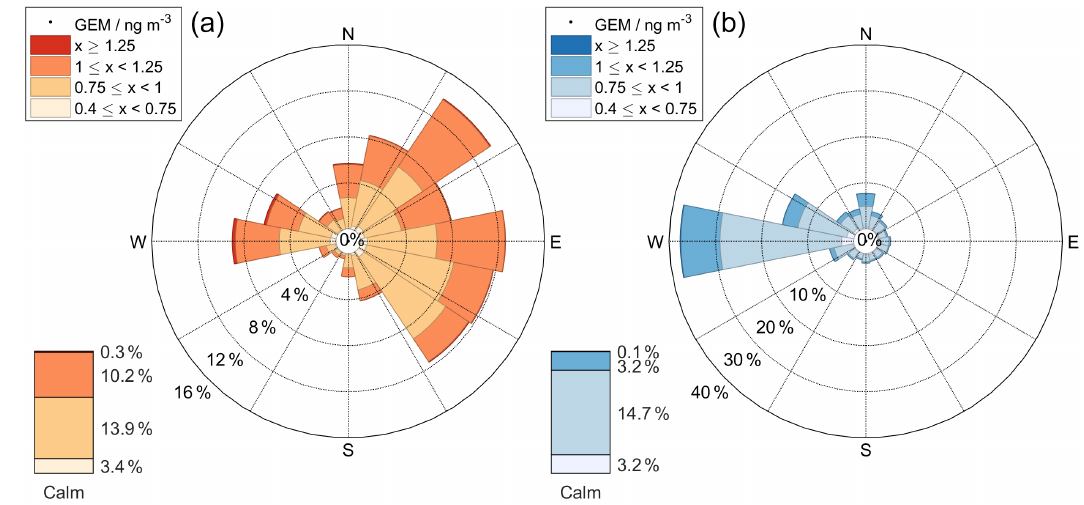
Figure 3. Directional GEM concentration distributions for (a) dry season and (b) all wet-season half-hourly GEM